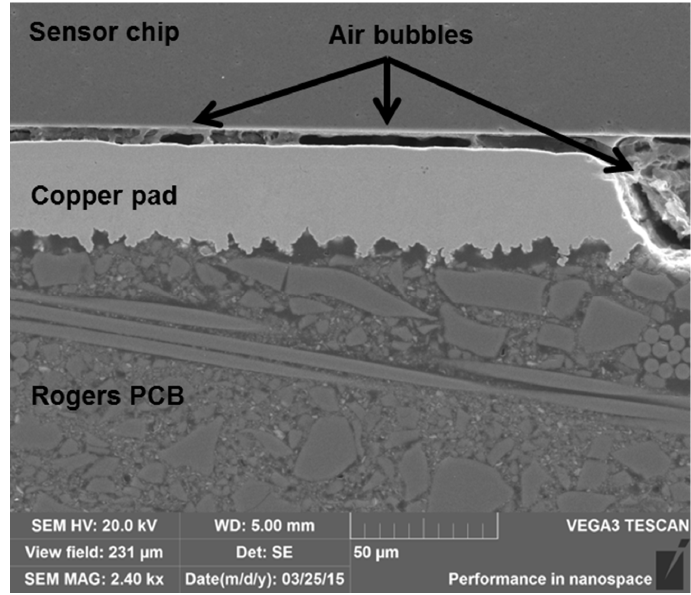
Figure 14. SEM micrograph showing air bubbles in the Rogers sample after 22 h of aging at 240 °C.